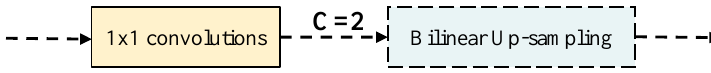
Figure 6. Architecture of the light-weight